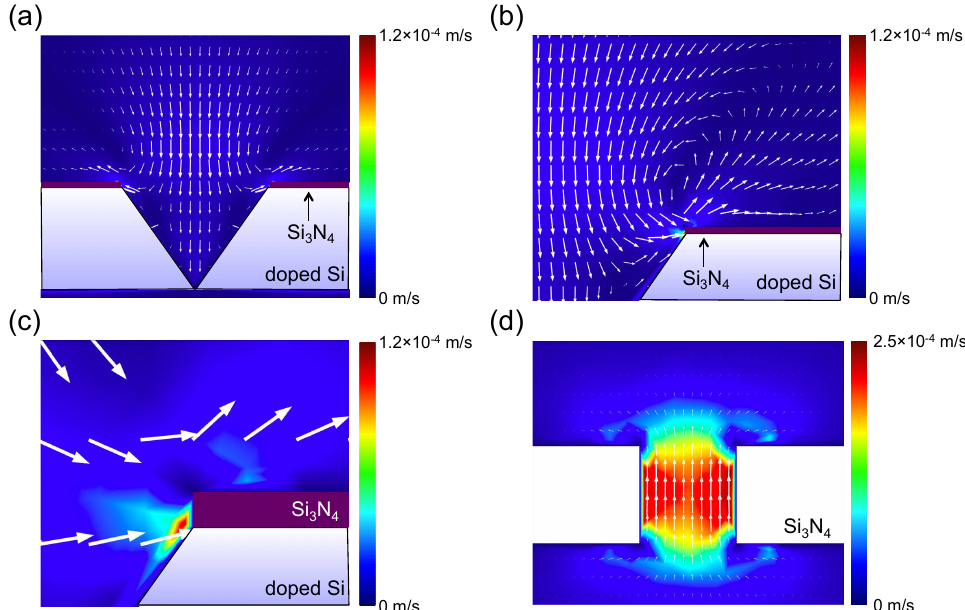
Figure 5. Simulated electroosmotic flows. ( a ) Electroosmotic flow velocity distribution in the Si 3 N 4 / doped Si ( ε r = 11.7) IP-shaped nanopore device. ( b , c ) Magnified views of the distribution in the Si 3 N 4 / doped Si IP-shaped nanopore device. ( d ) Electroosmotic flow velocity distribution in the cylindrical Si 3 N 4 nanopore device. The electroosmotic flow in the IP-shaped nanopore seems to cause positive e ff ects for the device